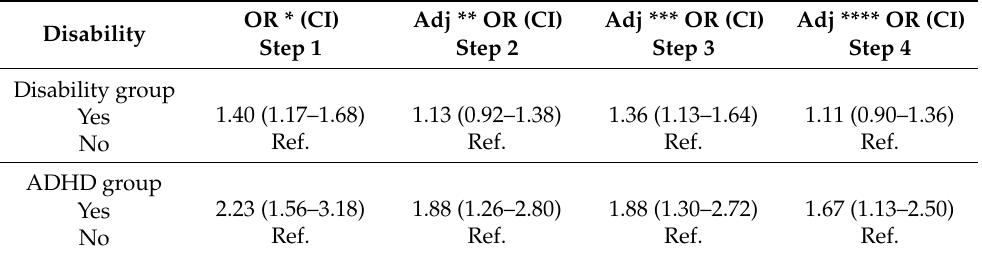
Table 2. The association between poor school-related well-being and self-reported disabilities or